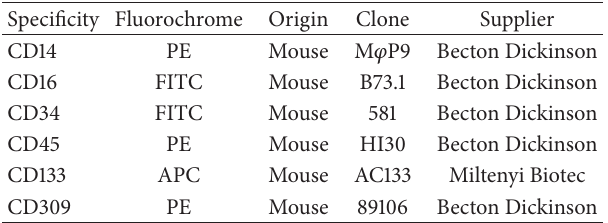
Table 2: Monoclonal antibodies used for flow cytometry